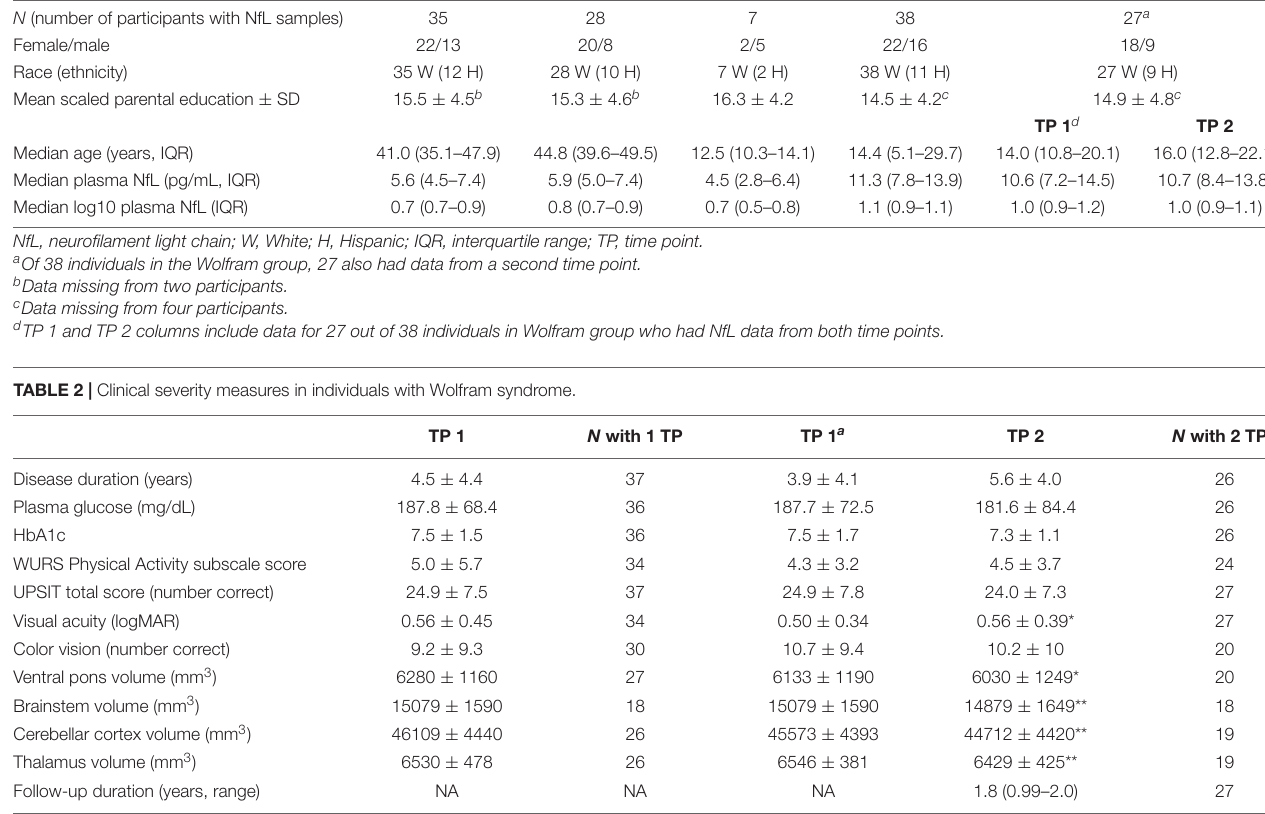
TABLE 1 | Control and Wolfram group demographics and plasma neurofilament light chain levels. All controls